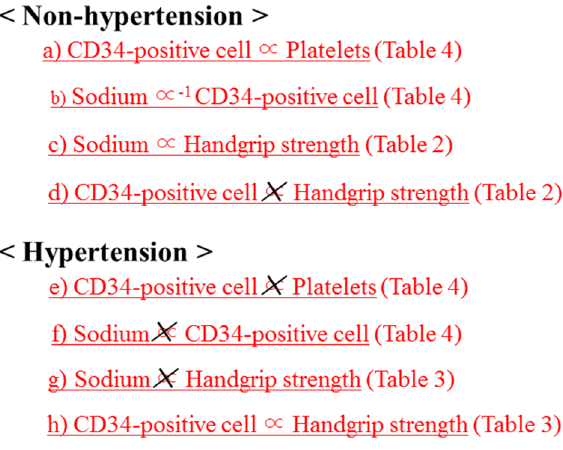
Figure 1. Associations observed in the present